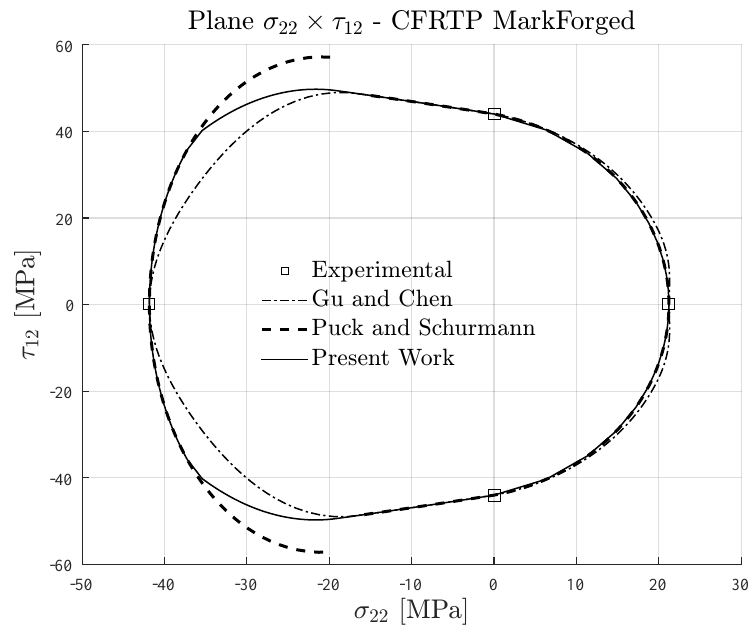
Figure 8. Failure envelopes on the stress space σ 22 × τ 12 for 3D-printed continuous carbon fiber reinforced thermoplastic lamina. Inclination parameter p c ⊥⊥ = 0.3 for Puck and Schürmann and Expanded Puck and